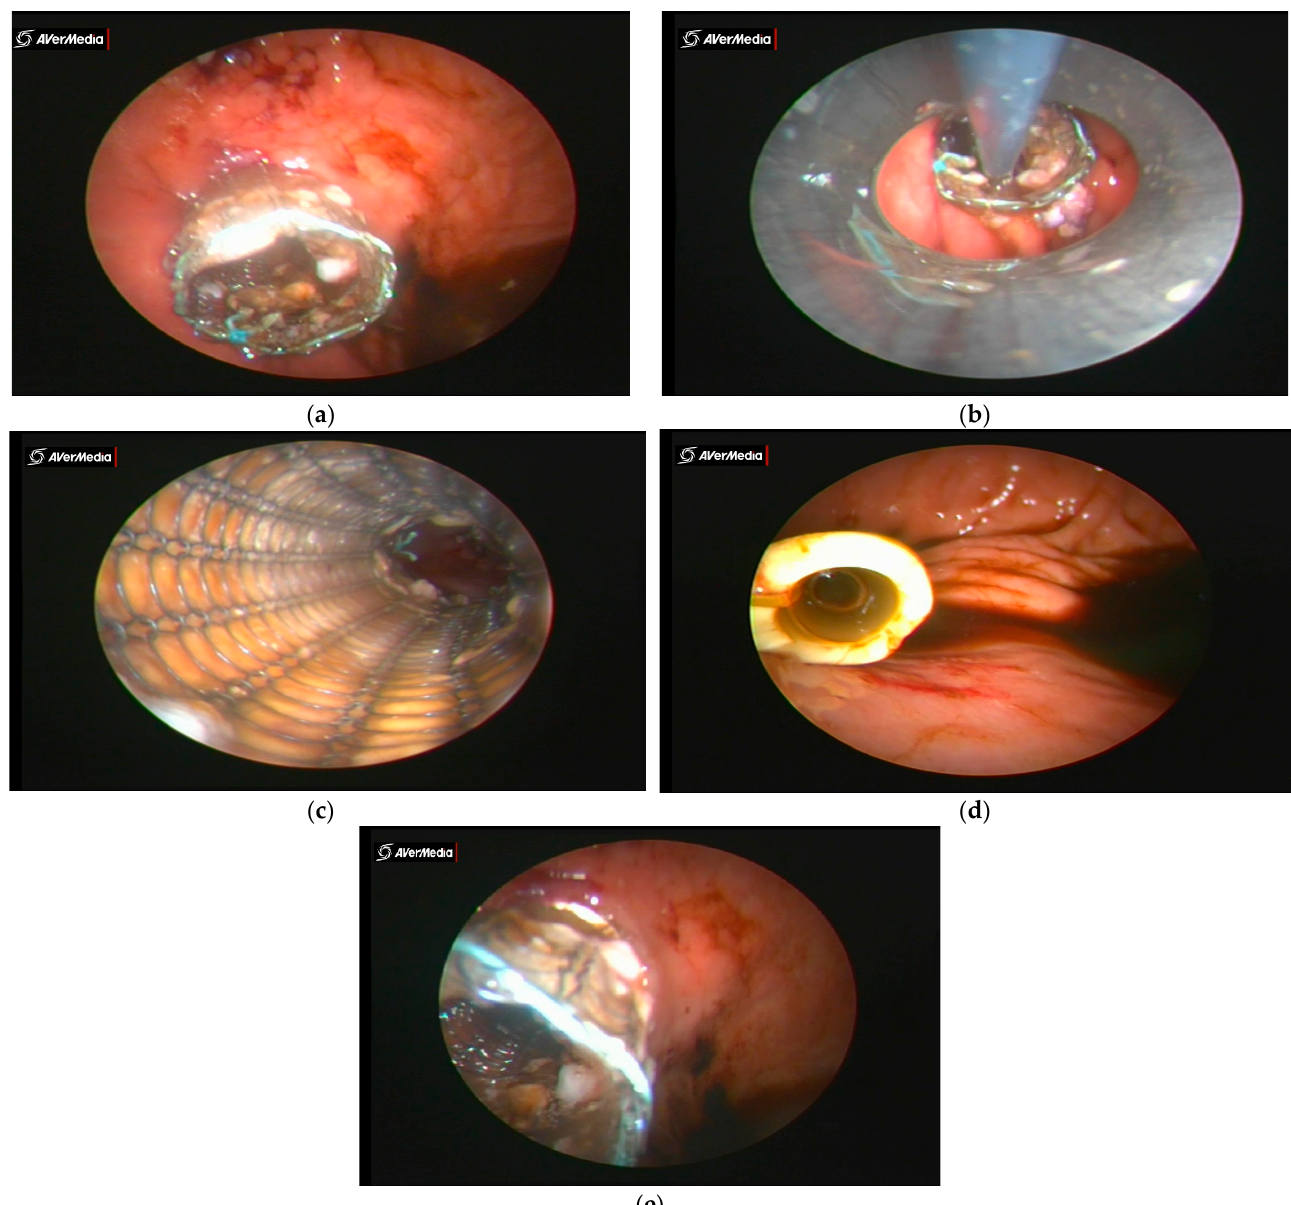
Figure 4. ( a ) Endogastric image of distal end of SEMS prosthesis crossing the cardial orifice. ( b ) Collection of bioptic material after drilling. ( c ) Proximal endoprosthetic view and SEMS. ( d ) Silicone prosthesis distal end—endogastric image. ( e ) Endogastric image of distal end of flexometallic prosthesis through the cardial orifice—tumor at ⅓ of distal esophagus.